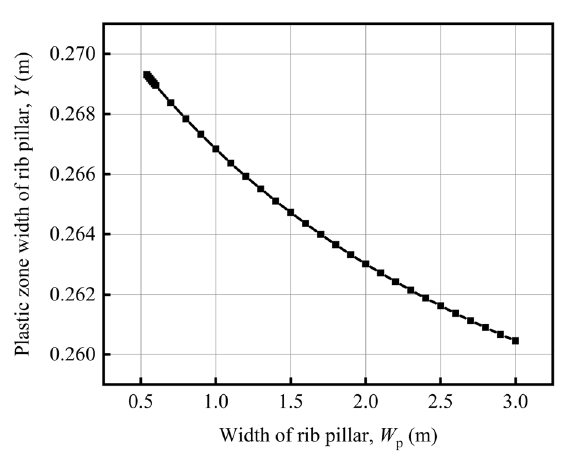
Fig. 9 Section view of end slope in an open-pit mine